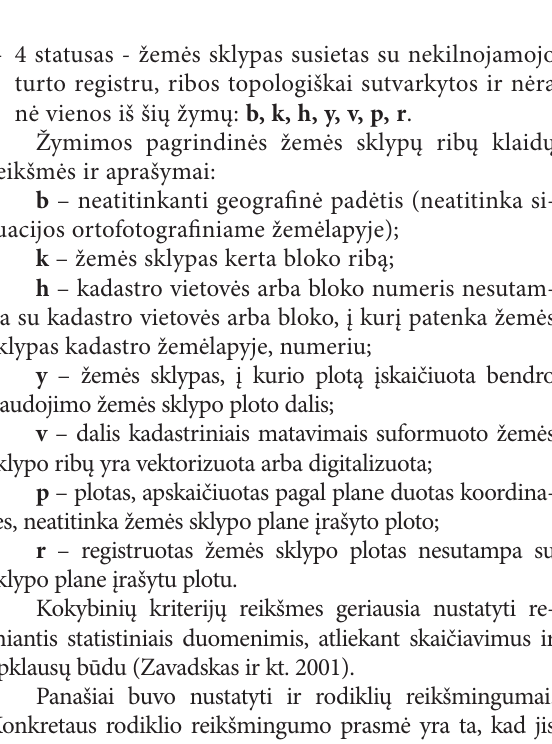
Table 1. The initial decision-making matrix of the land parcels of Vilnius municipalitys Žemės sklypų, suformuotų atliekant preliminarius matavimus, skaičius Savivaldybės